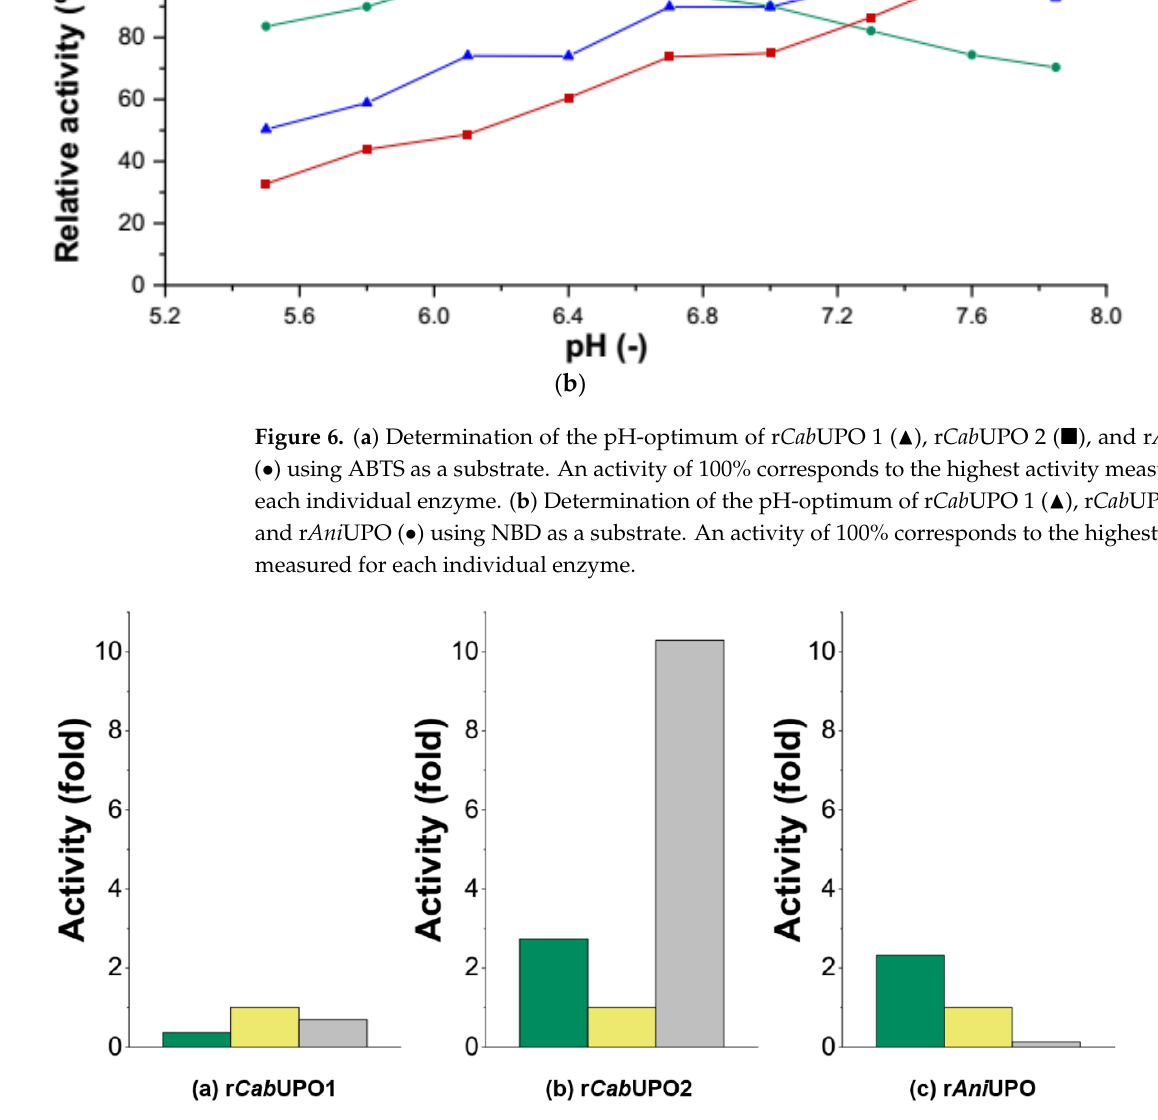
Figure 8. Amino acids defining the substrate access channel of r Ani UPO (left) and Mro UPO (right) in a top-down view from the protein surface to the channel bottleneck. Main-chain secondary struc- tures are shown as cartoon helices (red) or loops (green). Side-chains (depicted as sticks) are labeled using the IUPAC standard one-letter amino acid code. The field-of-view was reduced to 60° (aids depth-perception and reduces visual cluttering). The solvent excluded surface (SES) of the channel- lining amino acids is depicted as a colored mesh (ignoring all other amino acids). The meshes are colored from blue (bottleneck distal) to orange (bottleneck proximal) and are colored in approxima- tion as the amino-acid side-chains that either form the channel-bottleneck (in orange) or rather the